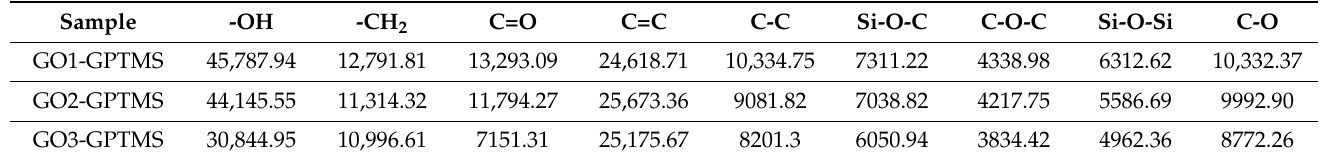
Table 4. Area under the curve of the signal corresponding to GOs functionalized with